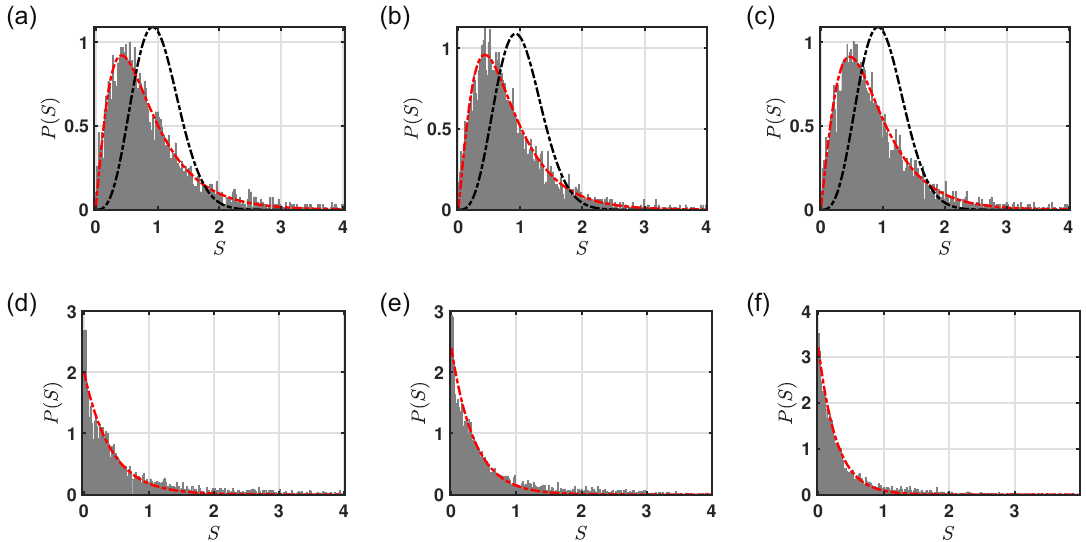
Figure 7. Level spacing statistics of the Green’s matrix eigenvalues for two different regimes: ρλ 2 = 0.05 (panels ( a – c )) and ρλ 2 = 50 (panels ( d – f )). Panels ( a – d ), ( b – e ), ( c – f ) refer to EC H , EC M , and EC L configurations, respectively. The fitting curves are performed by using the critical cumulative distribution [25,43,46] (dotted dashed lines in panels ( a – c )) and the Poisson distribution (dotted dashed lines in panels ( d – f )). The dotted dashed black lines in panels ( a – c ) indicates the level spacing distribution of a representative UR structure defined by Equation